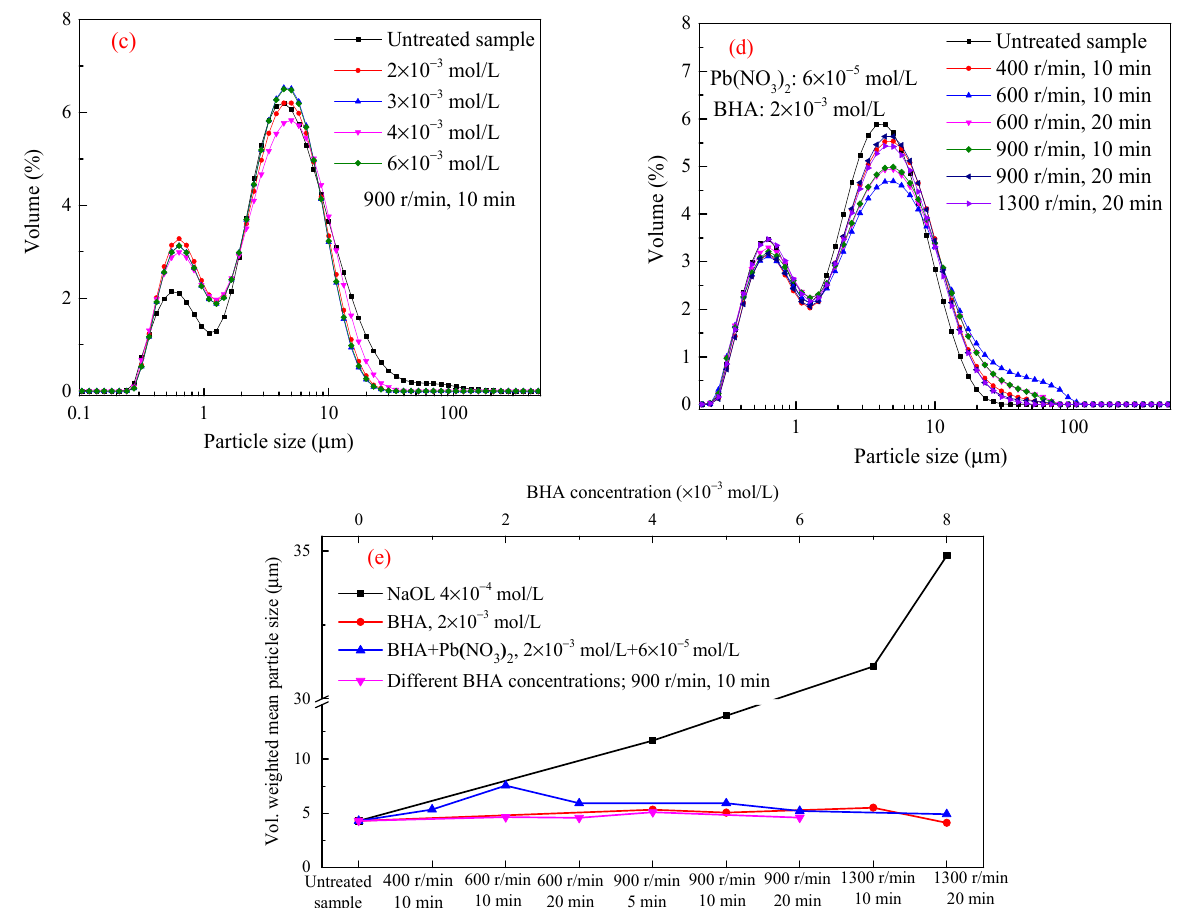
Figure 4. The particle size analysis results of − 10 µ m scheelite in the presence of NaOL ( a ), BHA ( b , c ), and BHA + Pb 2+ ( d ) under different conditions, ( e ): vol. weighted mean particle size (pH = 8.5–9).